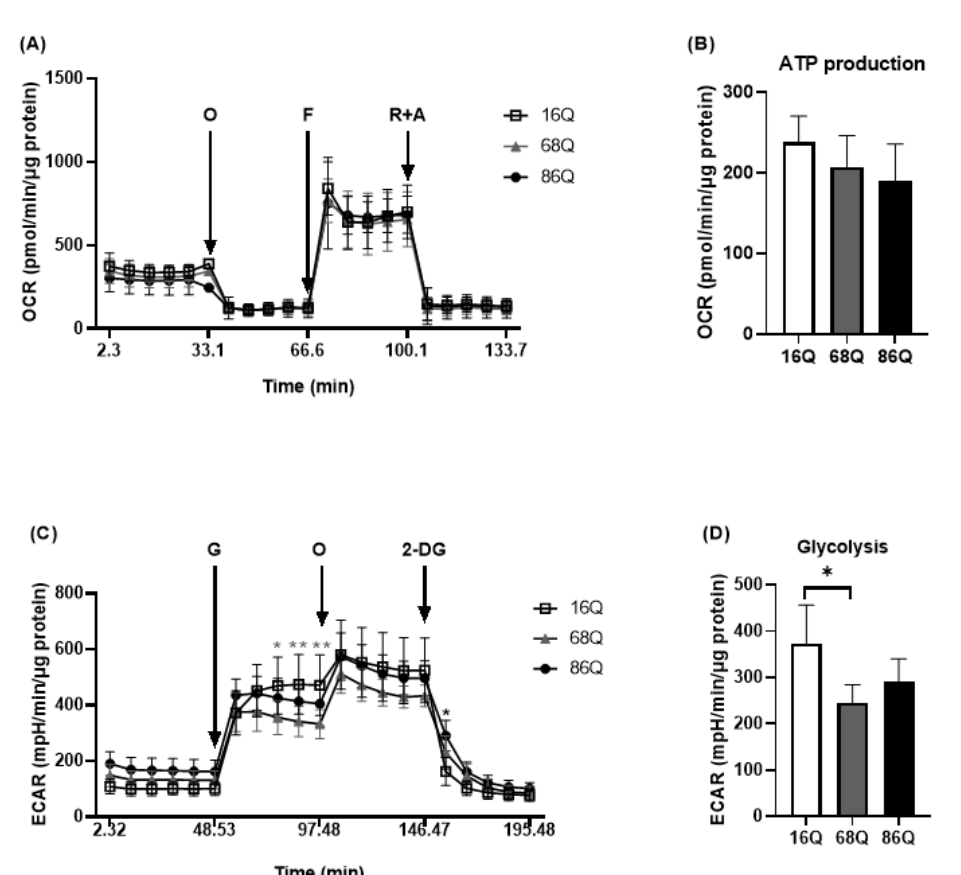
Figure 2. HD patients’ derived fibroblasts show reduced mitochondrial and glycolytic activity. The bioenergetics profile of mitochondrial activity and glycolytic assay were performed using Seahorse XF 96 analyzer. ( A , B ) HD (68Q and 86Q) and control (16Q) fibroblasts were seeded in an XF96 cell culture microplate at 20,000 cell / well for 24 h. The following day the basal OCR was determined for 30 min prior to the injection of Oligomycin (1 µ M, O); Carbonylcyanide-4-(trifluoromethoxy) phenylhydrazone (1 µ M, F); and Rotenone (1 µ M, R) with Antimycin A (1 µ M, A). ( A ) Bioenergetics profile of mitochondrial function in juvenile HD (68Q and 86Q) and control (16Q) fibroblasts. ( B ) The bioenergetics profile of mitochondrial ATP production. Data are presented as mean values ± SD for three independent experiments. Data were analyzed using Wave Desktop software. Statistical analysis was performed using ANOVA test by GraphPad Prism 8.2.1 (* p < 0.05; ** p < 0.01, *** p < 0.001 **** p < 0.0001 compared to healthy control). OCR data were normalized to protein content (pmol / min / µ g protein). ( C , D ) Glycolytic function was assessed by measuring extracellular acidification rate (ECAR). HD (68Q and 86Q) and control (16Q) fibroblasts were seeded in an XF96 cell culture microplate at 20,000 cell / well for 24 h. The following day, the media was replaced with glucose-free media and cells were incubated for 1 h without CO 2. The basal ECAR was determined for 30 min in glucose-free medium prior to the injection of 10 mM glucose (G), 1 µ M olygomycin (O), and 50 mM 2-deoxy-d-glucose (2-DG) ( C ) Glycolytic profile of HD (68Q and 86Q) and control (16Q) fibroblasts. ( D ) Measure of glycolysis as the ECAR rate after the addition of saturating amounts of glucose production. Data are presented as mean values ± SD for four independent experiments. Data were analyzed using Wave Desktop software. Statistical analysis was performed using ANOVA test by GraphPad Prism 8.2.1 (* indicates p < 0.05, ** indicates p < 0.01 compared to healthy control). ECAR data were normalized to protein content (pmol / min / µ g